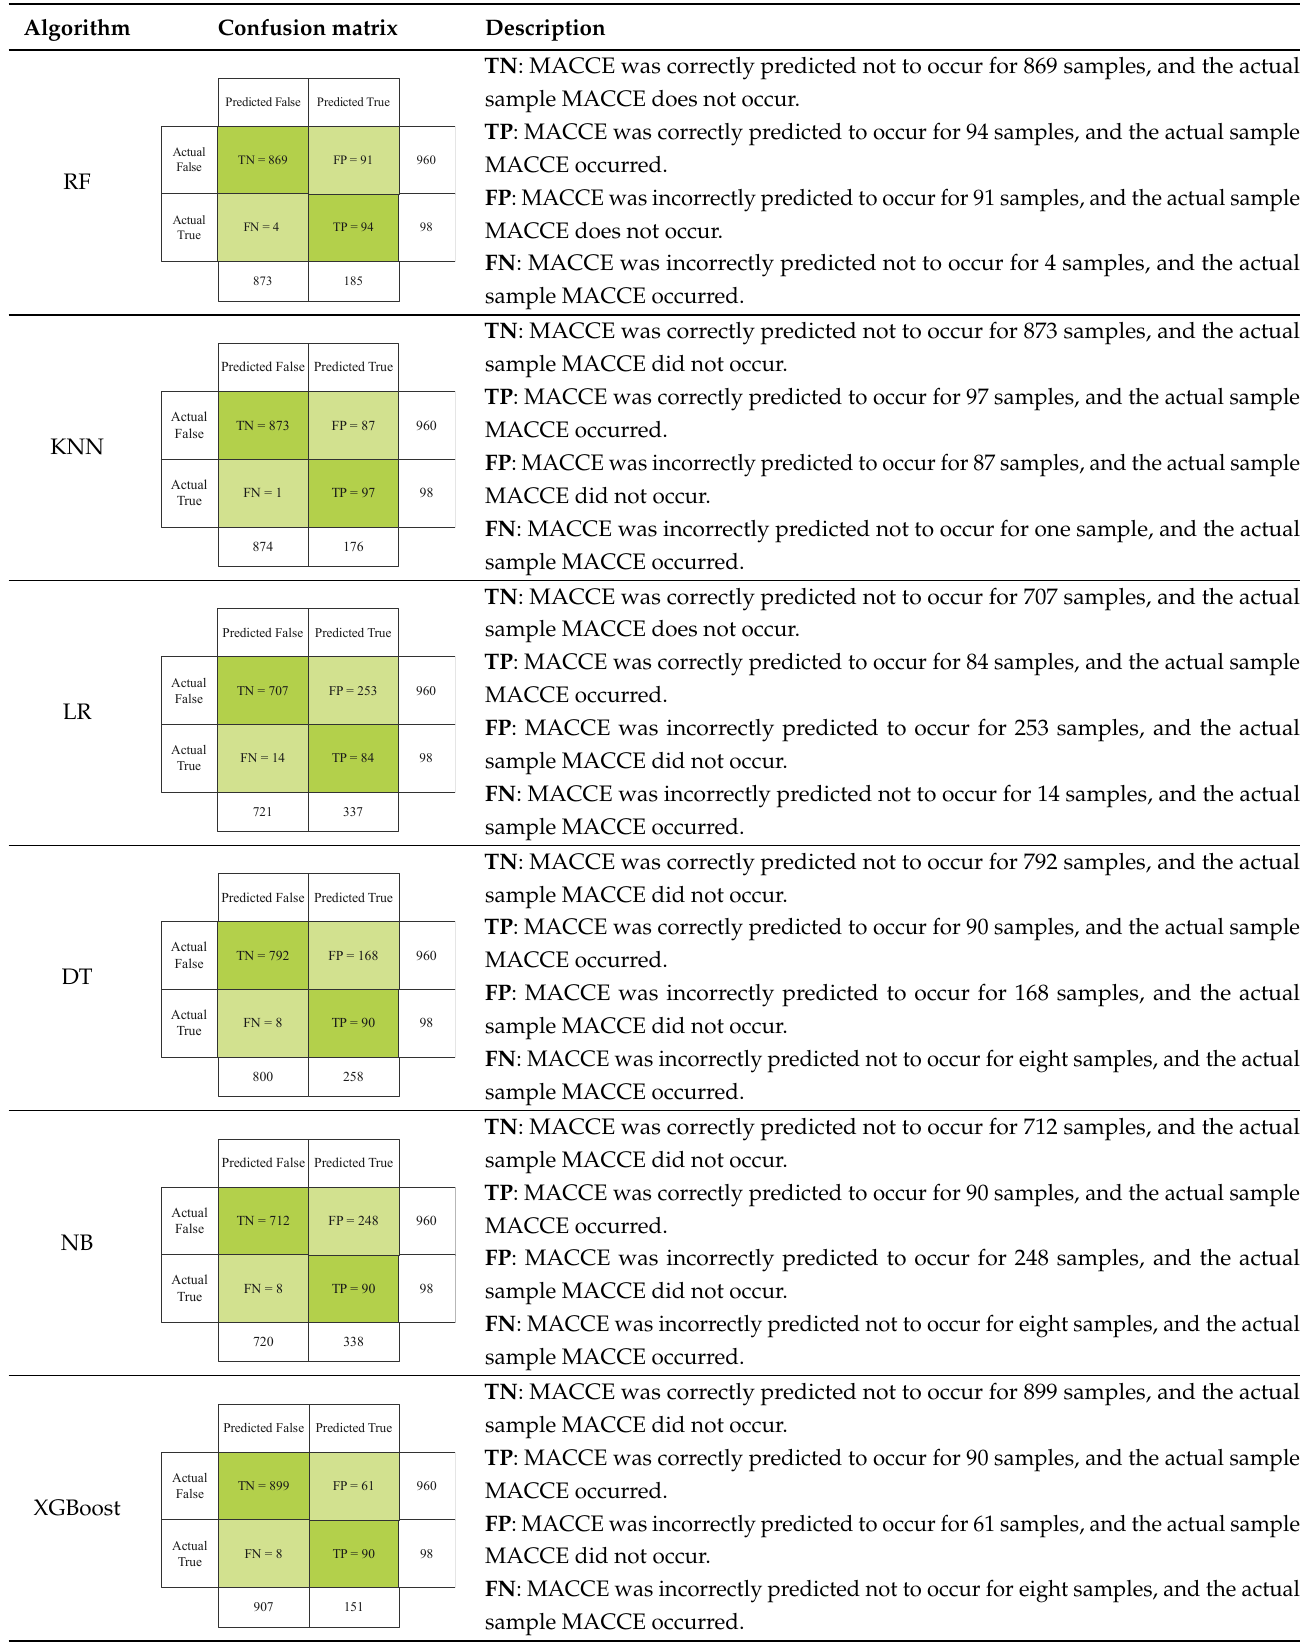
Table 3. The confusion matrix of six